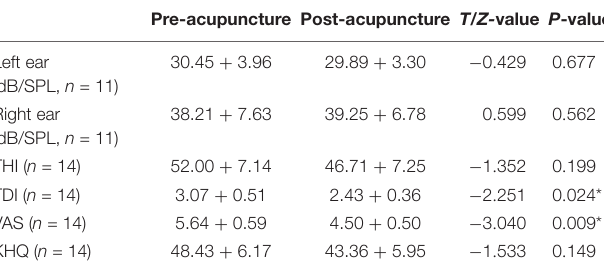
Frontiers in Neuroscience |